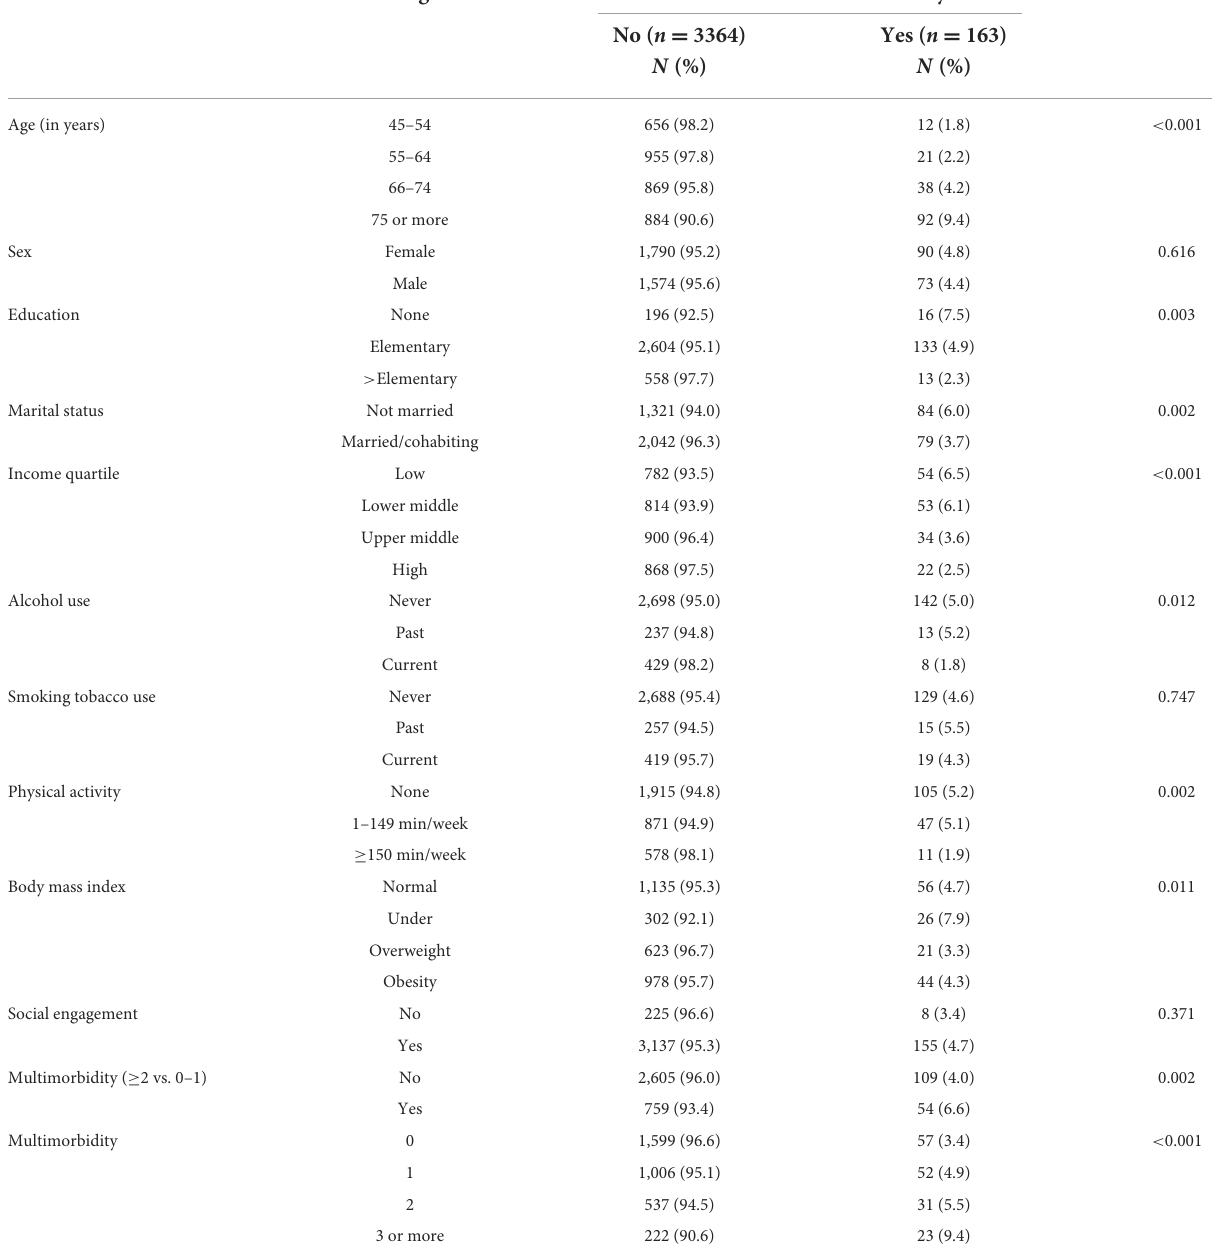
TABLE 3 Sample characteristics of participants with incident functional disability, Thailand,